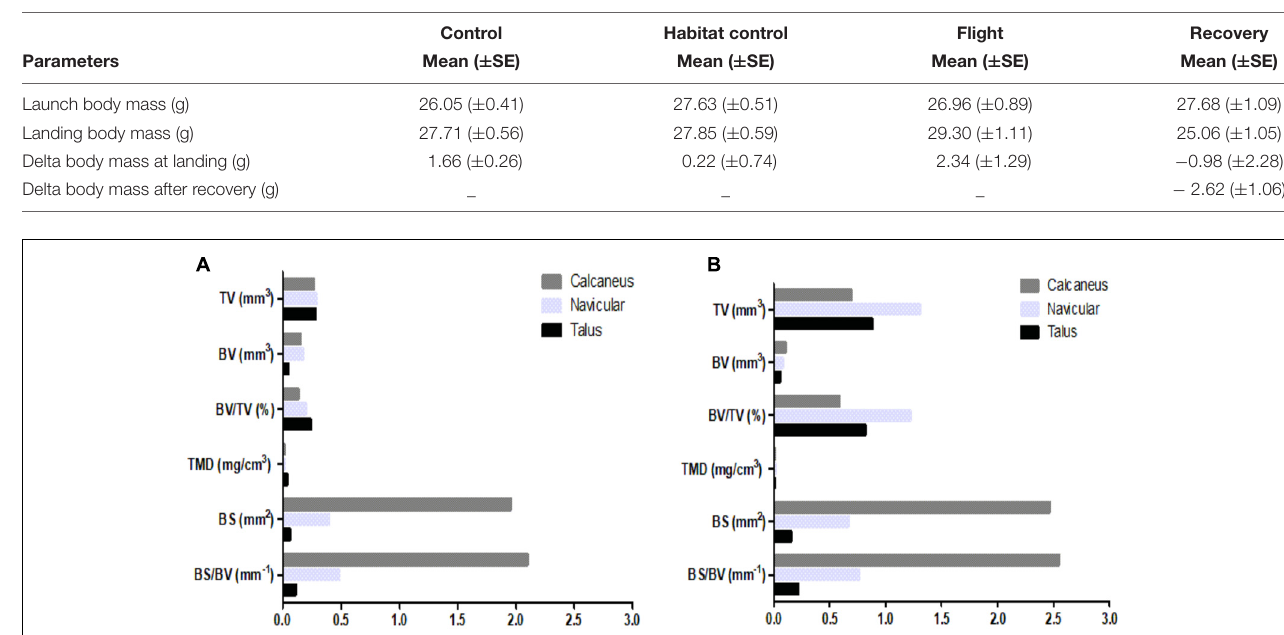
Control and Flight, and an increase in thinnest blue areas, predominantly between Control and Recovery. These two areas showing greatest cortical thinning correspond with the sub-talar articulation and the point of ground contact.